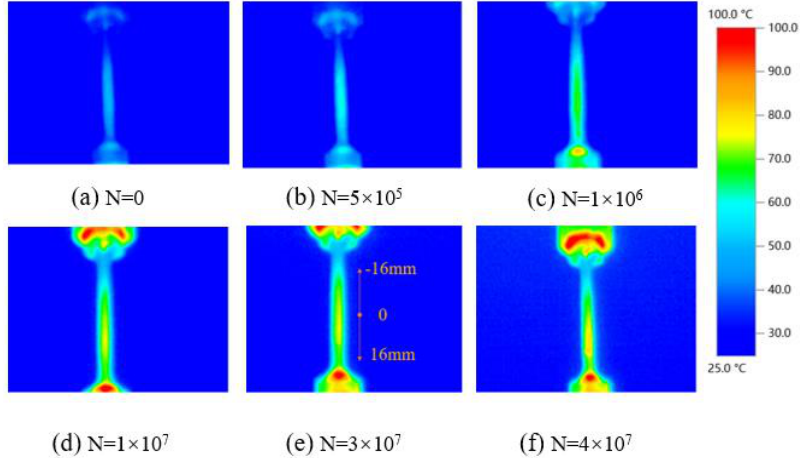
Figure 3. Full-surface view of thermography measurements of welded joint under different cycles at σ a = 645 MPa (the stress level is beyond yield point meaning obvious frequency effect): ( a ) N = 0, ( b ) N = 5 × 10 5 , ( c ) N = 1 × 10 6 , ( d ) N = 1 × 10 7 , ( e ) N = 3 × 10 7 , ( f ) N = 4 × 10 7 .